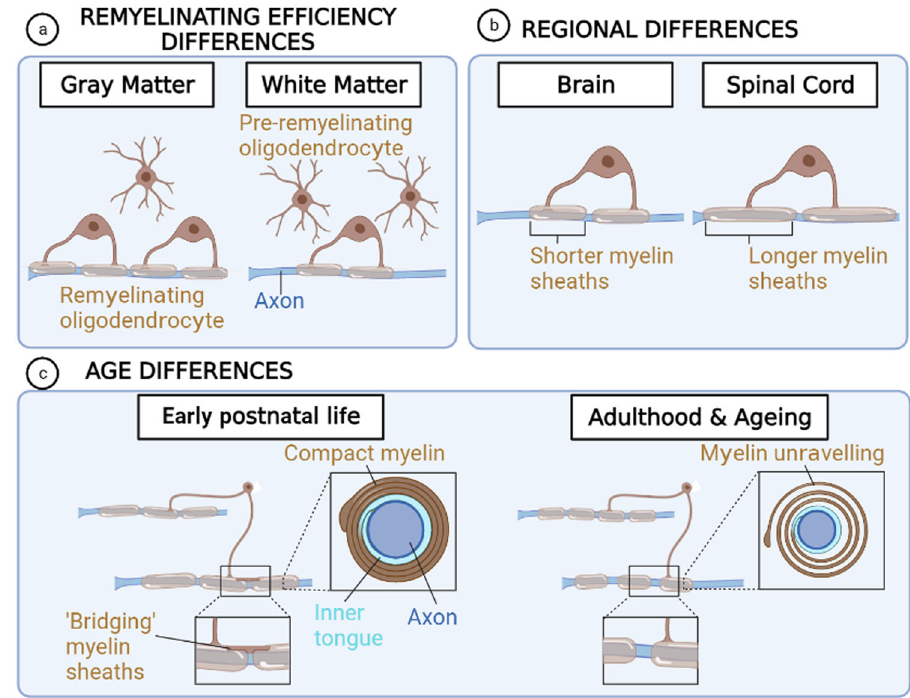
Fig. 3 Oligodendrocyte Heterogeneity. a Remyelinating ef fi ciency differences are observed between the gray matter and the white matter, oligodendrocytes in the former remyelinate more ef fi cient than the latter, where oligodendrocytes have a higher capacity to differentiate. b Oligodendrocytes show regional differences, in the brain forming shorter myelin sheaths than in the spinal cord. c Oligodendrocyte differences exist during the lifespan, when during early postnatal life oligodendrocytes form compact myelin and longer myelin sheaths, and can create bridges forming sequential myelin sheaths known as ‘ bridging myelin sheaths ’ . In adulthood and ageing, myelin sheaths are shorter and uncompact, leading to myelin unravelling and loss of the bridging myelin sheaths. Created using